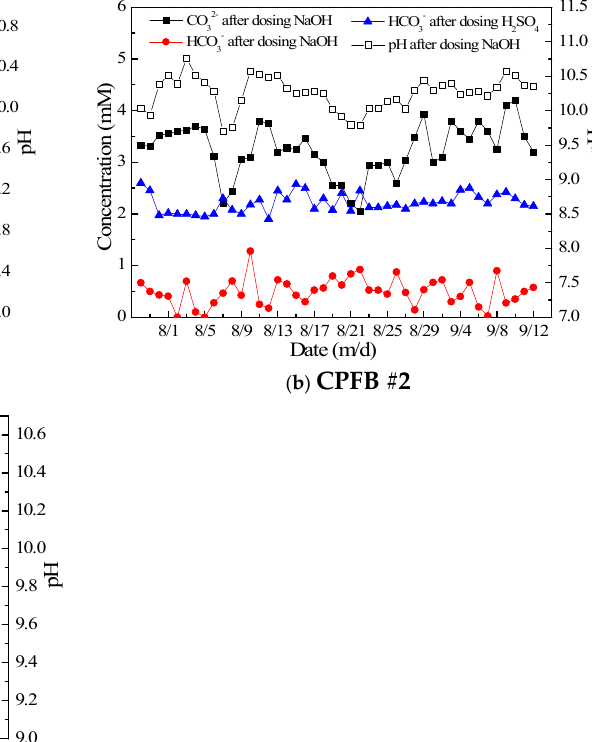
Figure 4. Dosage and cost of the chemicals used in the system under different pH conditions.